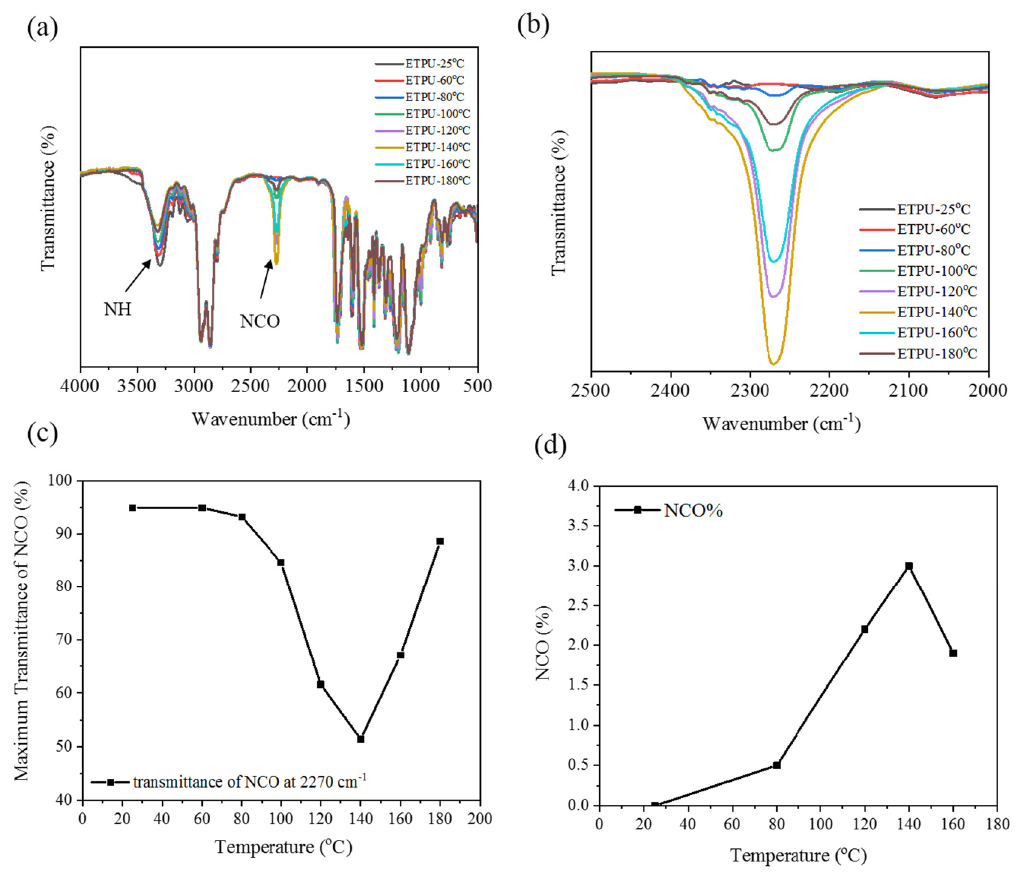
Figure 3. Variable-temperature FT-IR spectra of ETPU with reversible urethane bonds: ( a ) FT-IR spectra for the copolymers at 4000~500 cm − 1 ; ( b )FT-IR spectra at 2000~2500 cm − 1 ; ( c ) Transmittance change at 2270 cm − 1 at elevated temperatures; ( d ) Change of NCO% at elevated temperatures.